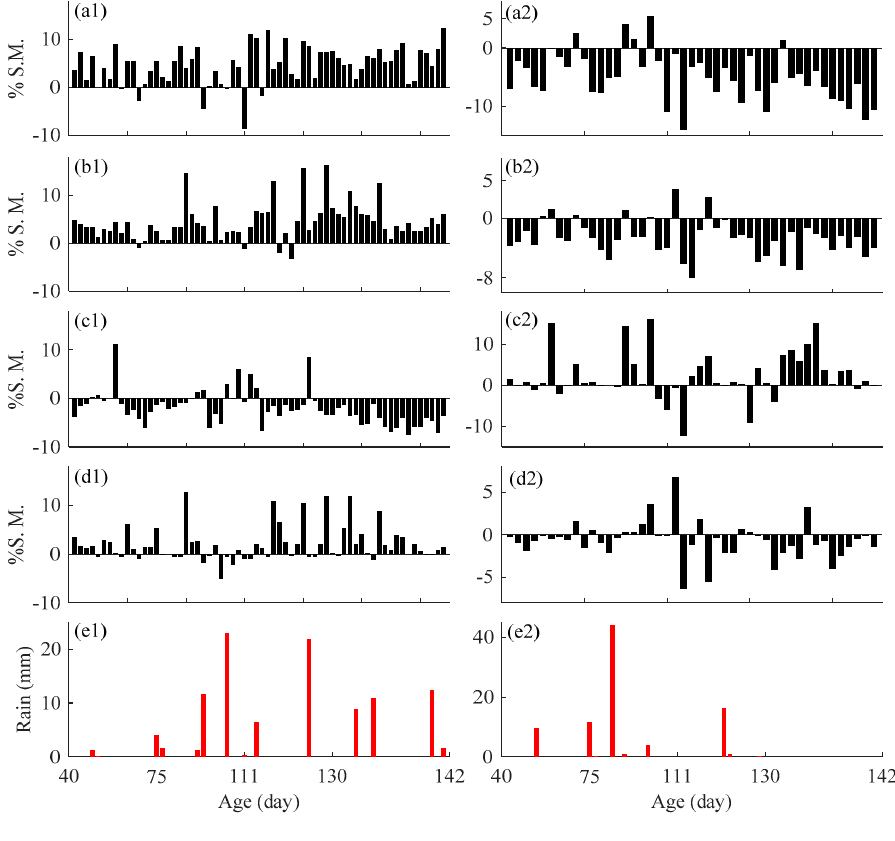
Figure 5. Soil moisture (SM) fluctuations in different treatments during the irrigation period (DIP; 08.00 h–16.00 h, a1, b1, c1 and d1 in T1, T2, T3 and T4) and outside the irrigation period (OIP; 16.00 h–08.00 h, a2, b2, c2 and d2 in T1, T2, T3 and T4), on day 40–142 of Eucalyptus pellita growth, e1 and e2 timing and magnitude of rainfall events during the DIP and OIP